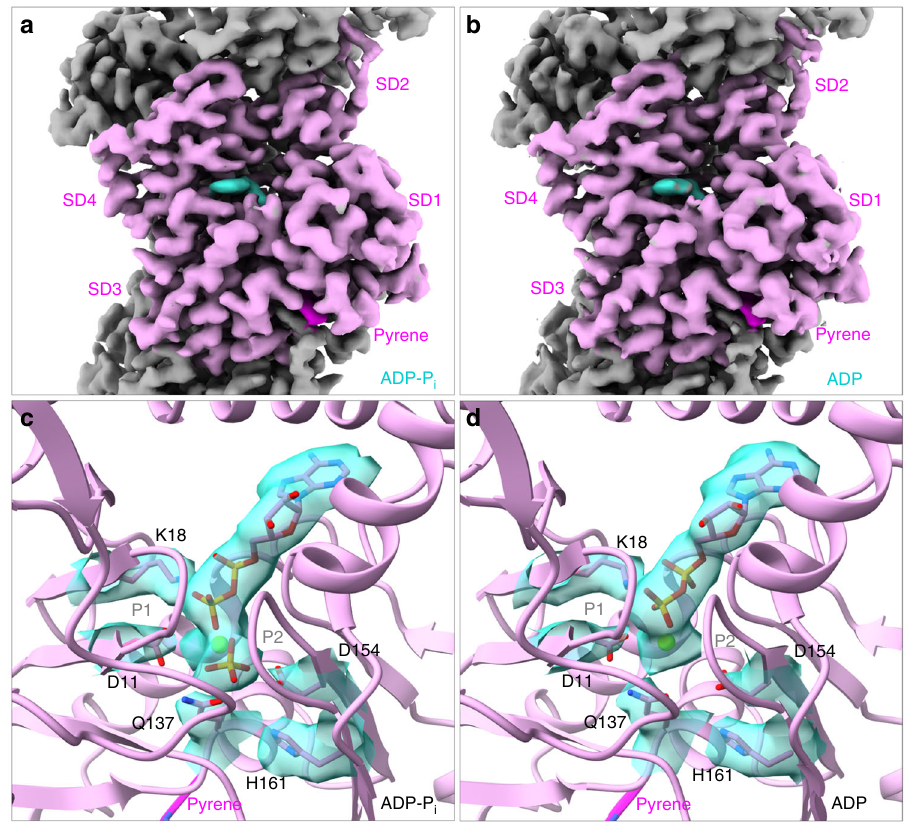
Fig. 1 Electron potential maps and ribbon diagrams of pyrenyl-actin fi laments with (a, c) bound Mg-ADP-P i or (b, d) bound Mg-ADP. a , b Maps with highlighted densities of the nucleotide (turquoise) and pyrene (magenta) in one subunit (plum). Neighboring subunits are gray. The barbed end is at the bottom. The four subdomains are labeled as SD1-4. c , d Ribbon models with the densities and stick fi gures of the bound nucleotides and a few key neighboring side chains. P1 (residues 11 – 16) and P2 (residues 154 – 161) are the two phosphate-binding